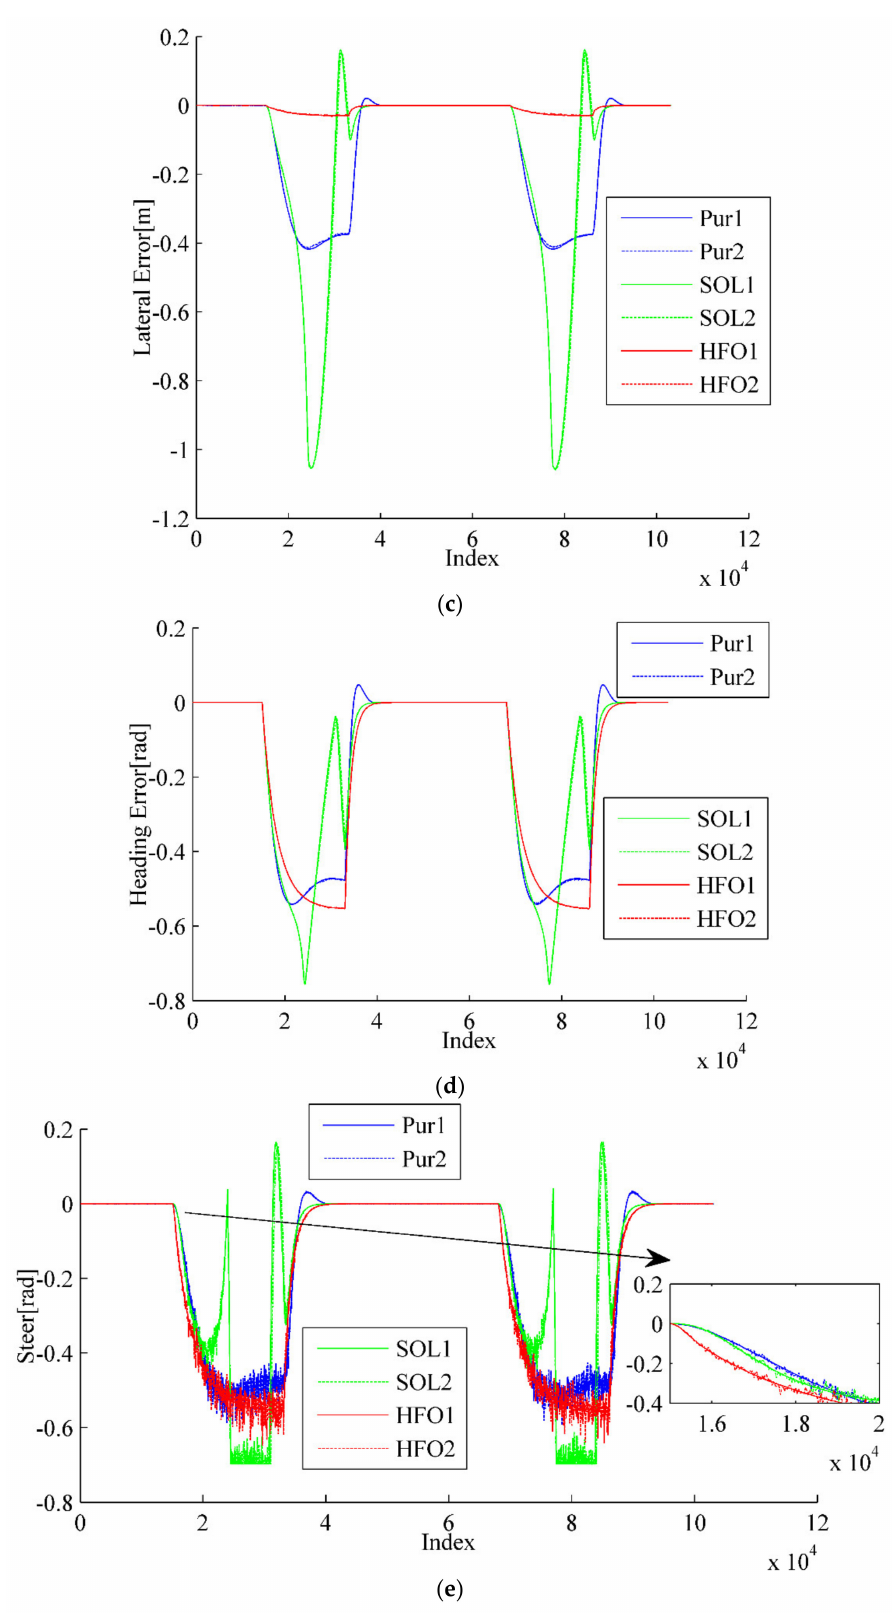
Figure 9. Ring test scenario. ( a ) Trajectory tracking (3D), ( b ) Trajectory tracking (2D), ( c ) Lateral error, ( d ) Heading angle, ( e ) Steer